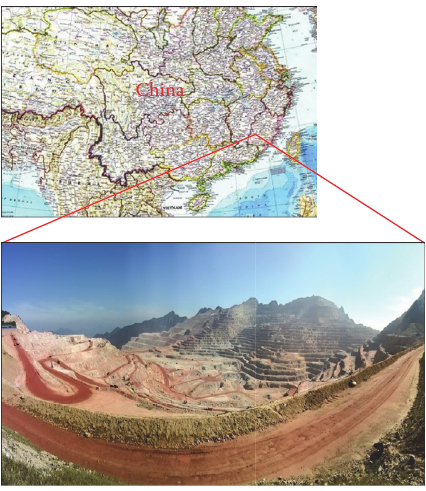
Figure 1: Location of the open-pit mine.